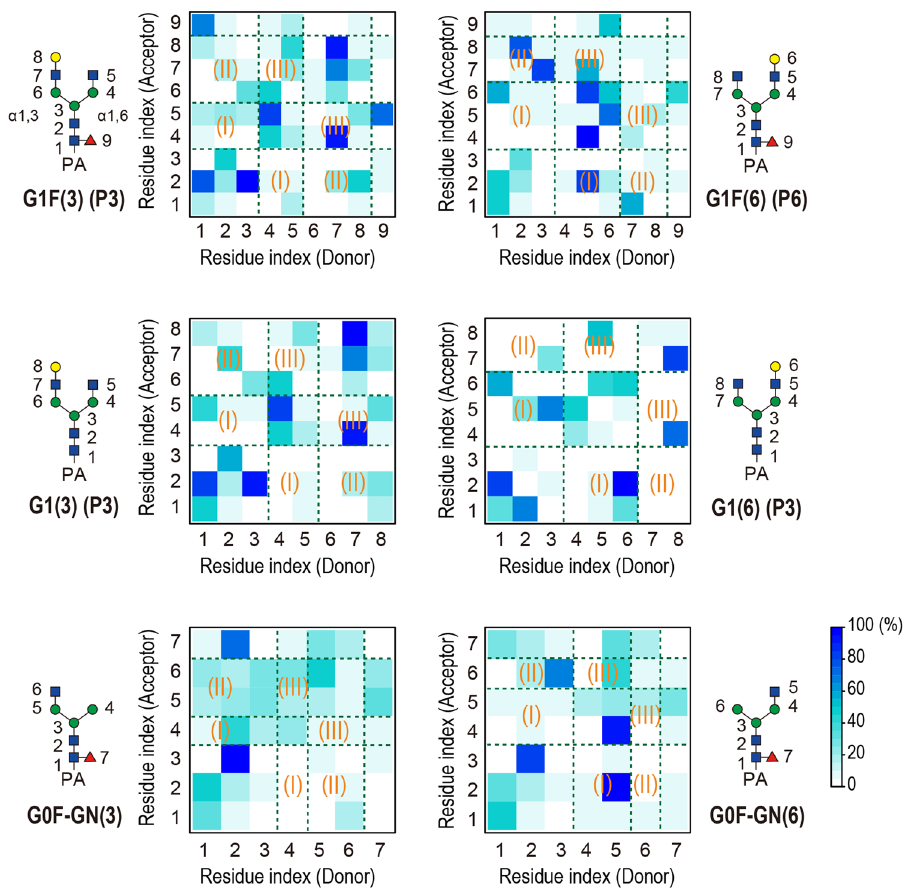
Figure 6. Residue-residue H-bond maps calculated for three pairs of isomeric PA-glycans with selected protonation states. The geometric definition was used to identify H-bonds: R XY < 3.5 Å and θ HXY < 30°, where R XY is the distance between heavy atoms X and Y, and θ HXY is the angle between X–H bond and X–Y vectors. The regions of inter-branch interactions are highlighted with Greek numbers (I: core chitobiose- α 1-6 branch, II: